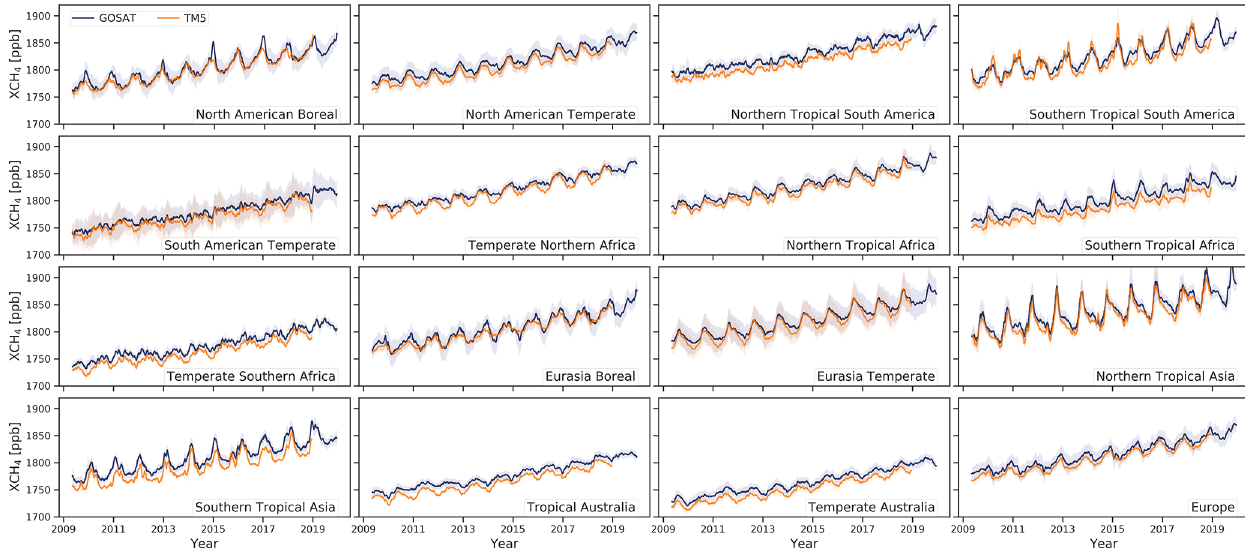
Figure 12. Time series comparison between the GOSAT Proxy XCH 4 data and TM5 model XCH 4 simulations (Bergamaschi et al., 2018b) for individual TransCom regions. The model data have been sampled at the time and location of the GOSAT observation and had the sounding-specific GOSAT averaging kernel